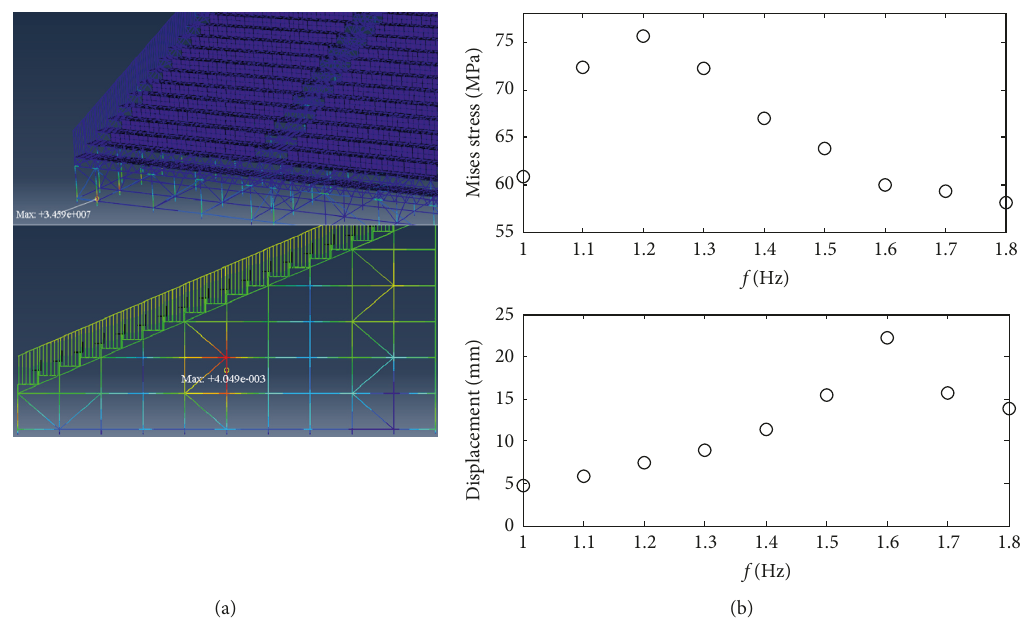
Figure 18: The significant response zone of structure and max structural response against swaying